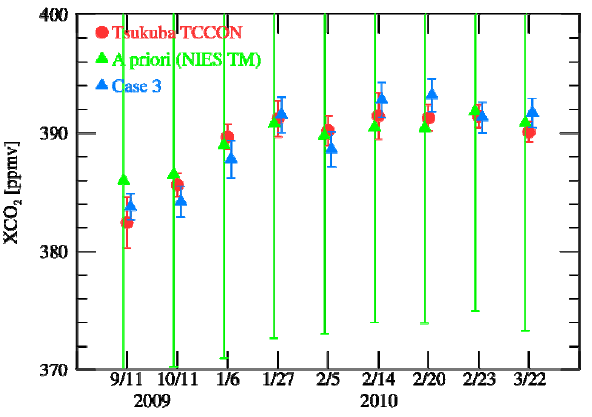
Fig. 9. Comparison of Case 3 XCO 2 data, obtained by retrieving the aerosol profile based on the a priori vertical profile and fixed aerosol optical characteristics given by the SPRINTARS model, with the Tsukuba TCCON XCO 2 data (Table 5, Case 3). The used a priori values and their error bars are also